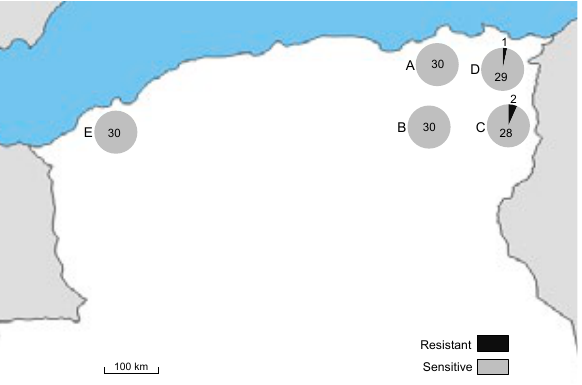
Figure 4. Distribution of azoxystrobin IC for 28 Zymoseptoria tritici Algerian isolates. Sensitive (IPO323) and resistant (T01193) reference isolates are pre- sented in